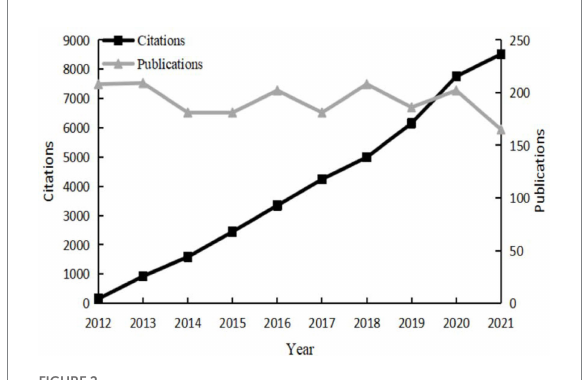
FIGURE 2 The annual publications and citations.